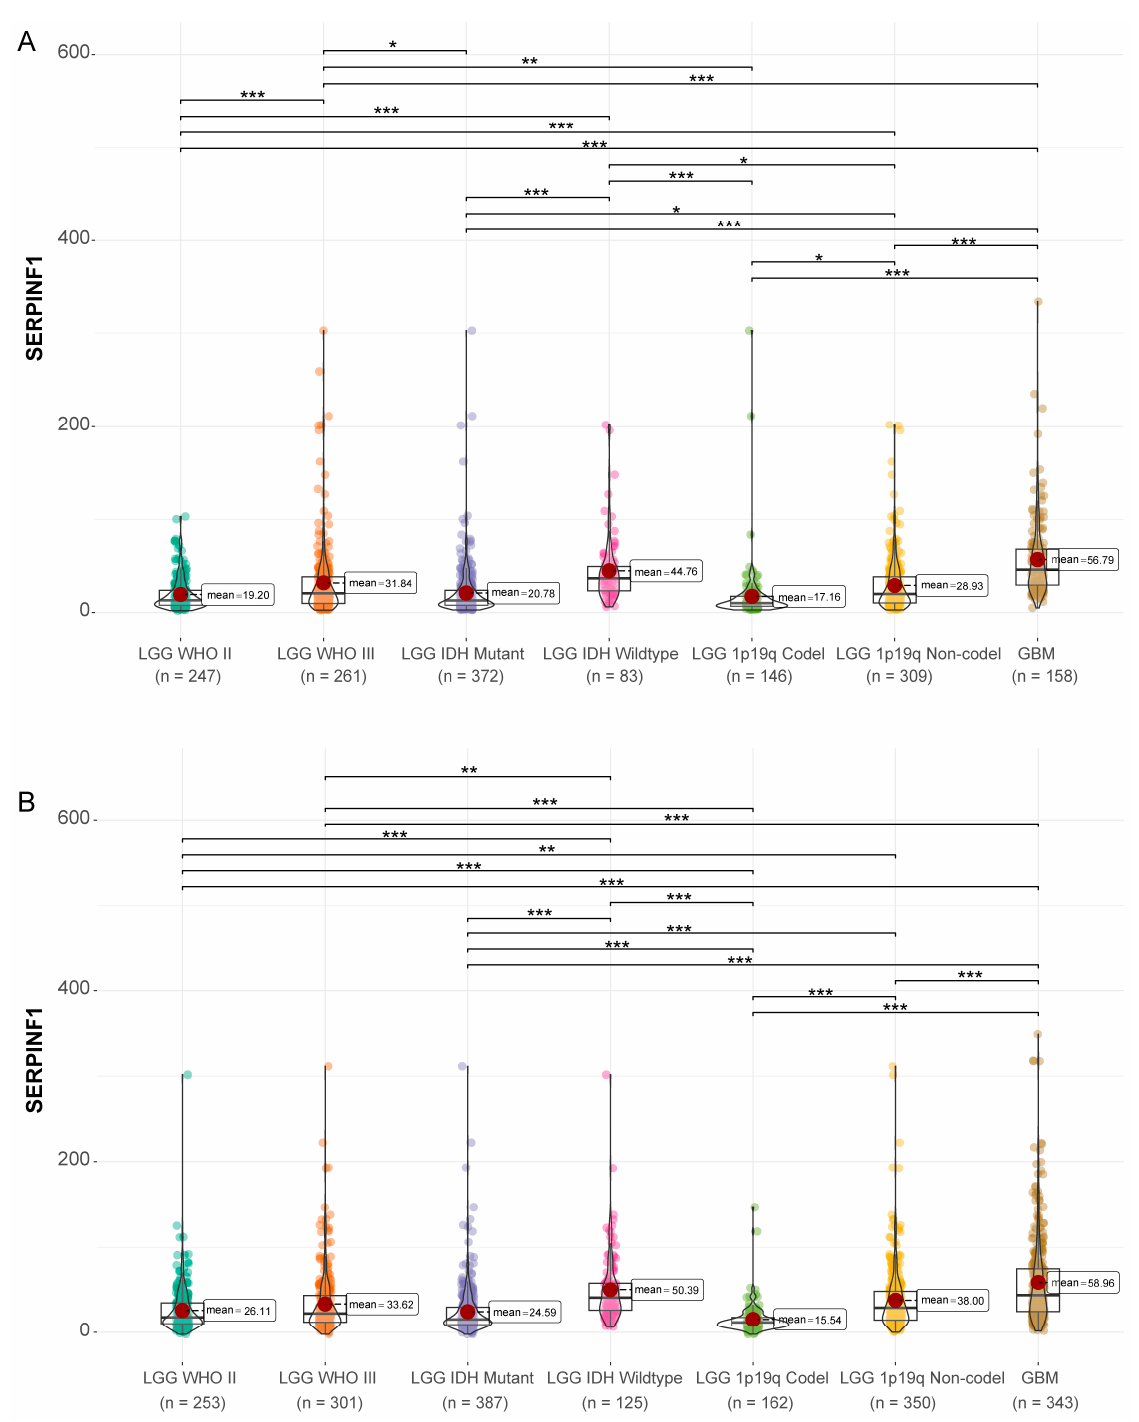
Figure 1. The expression of SERPINF1 in gliomas of different grades and molecular subtypes in TCGA ( A ) and CGGA ( B ). (* p < 0.05, ** p < 0.01, *** p < 0.001).